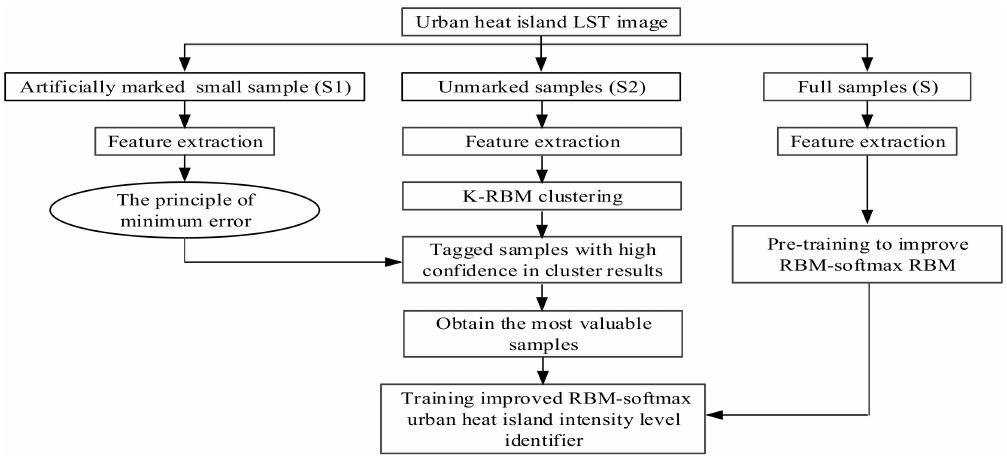
Figure 3. Construction process of the RBM model.